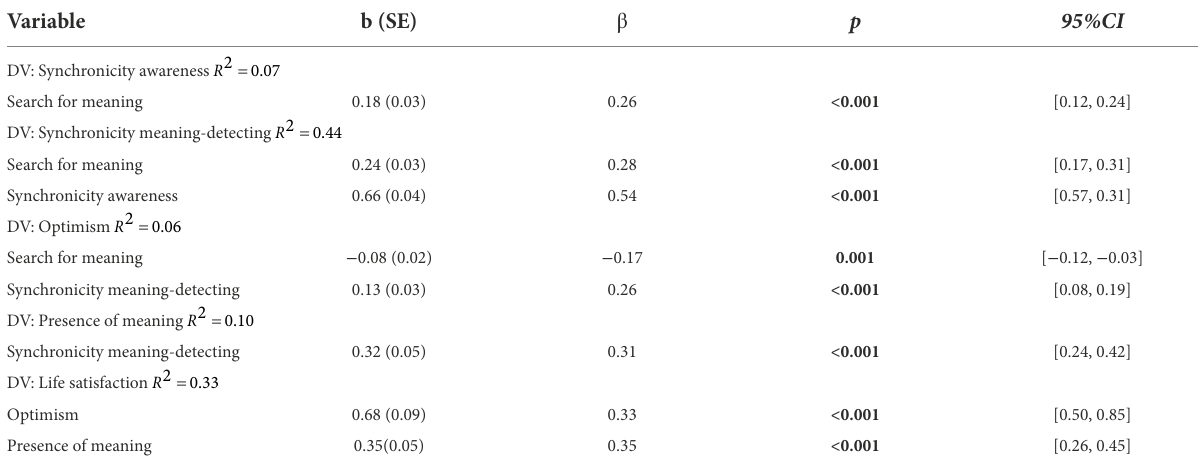
TABLE 5 Standardized and unstandardized coefficients in the path analysis